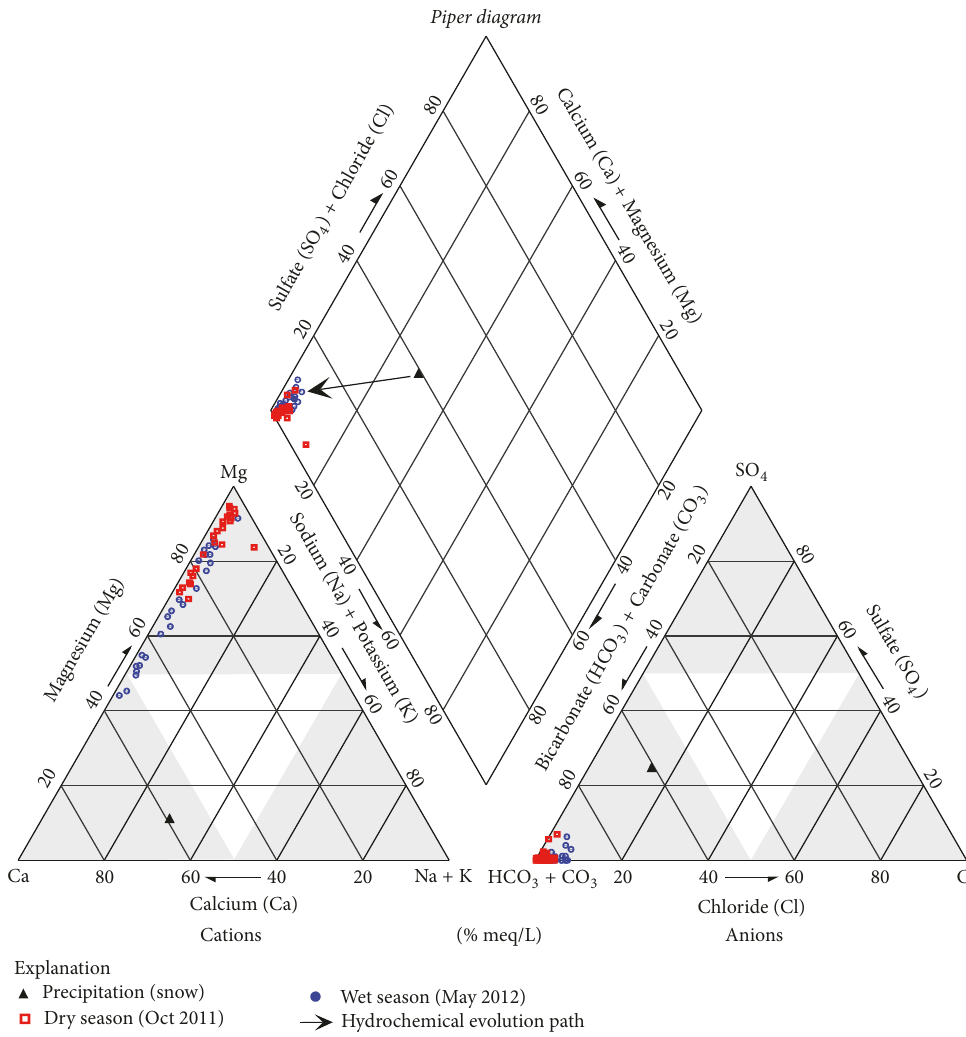
Figure 6: Piper diagram [90] showing the major ion composition (in %meq L −1 ) of the groundwater samples collected in dry season (October 2011)andwetseason(May2012)fromtheophioliticcomplexaquiferintheKızılgedikarea.Meansnowchemistry( 𝑛 = 11 )ofthesiterepresents the starting point in the hydrogeochemical evolution path of groundwater